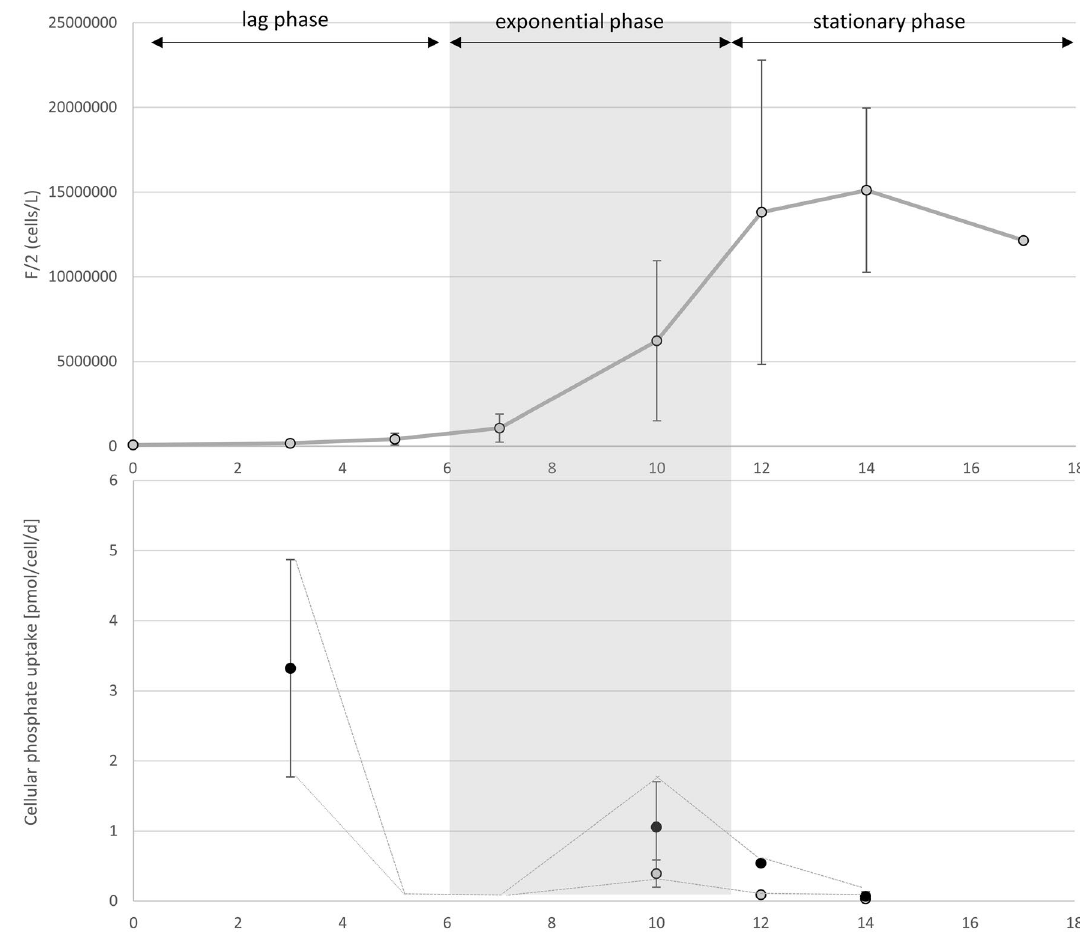
Figure 14. The dynamics of phosphate uptake rates for L. aporus throughout the experiment duration of batch cultures in F/2 medium. Dynamics of phosphate uptake rates throughout batch cultures of L. aporus in F/2 medium. ( a ) Average cell concentrations (and standard deviations) plotted over the duration of the batch culture in days. The phases of the growth curve are indicated. ( b ) Cellular phosphate uptake rates calculated as phosphate uptake divided by cell numbers at the days of phosphate quantification (blue, or lower values) and divided by the cell numbers at the day of the measurement before (orange, or higher values). The dashed line indicates lower and upper borders between the two calculation methods. The true uptake rate must be between the two borders. Note the steep drop of phosphate uptake rates during exponential